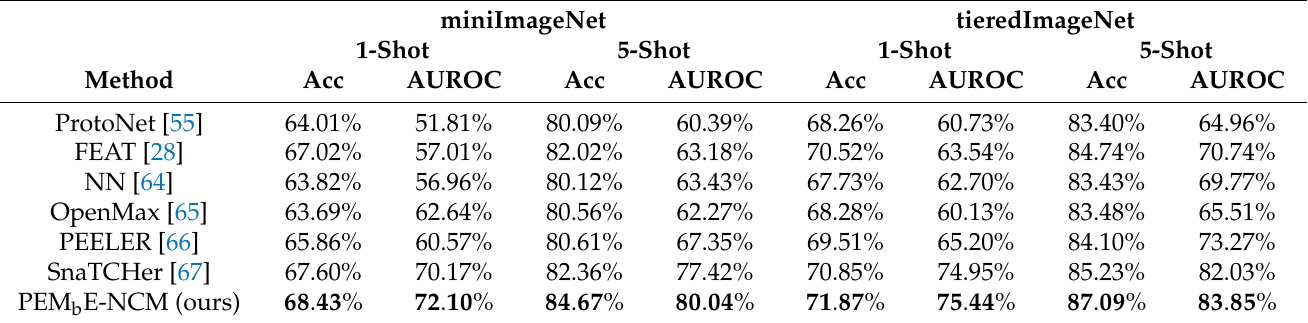
Table 8. Accuracy and AUROC of the proposed method for Few-Shot Open-Set Recognition. Best results are in bold.